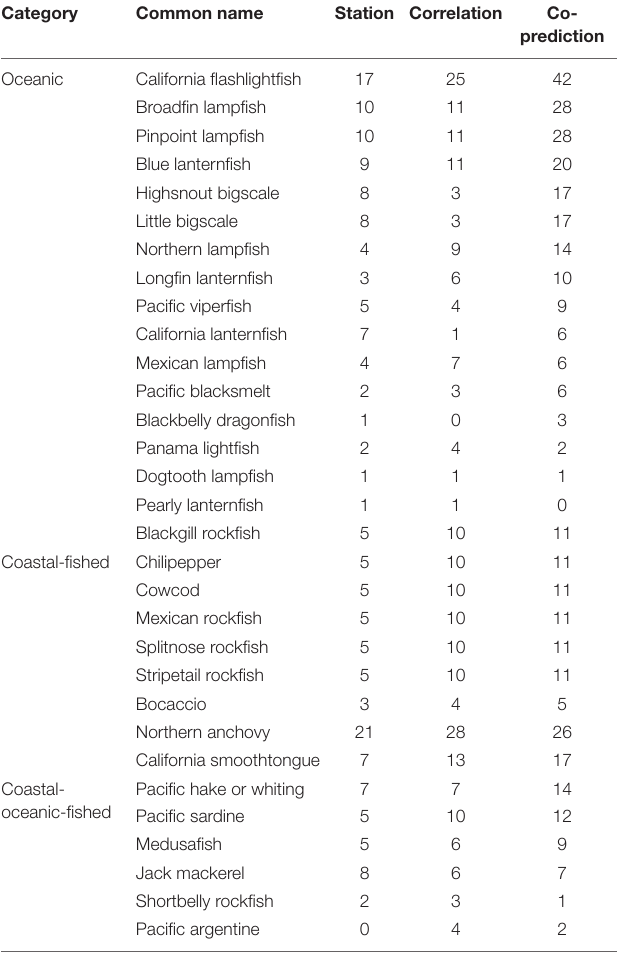
TABLE 4 | Numbers of significantly predicted stations with s-map prediction for each species, arranged by category. Category Common name Station